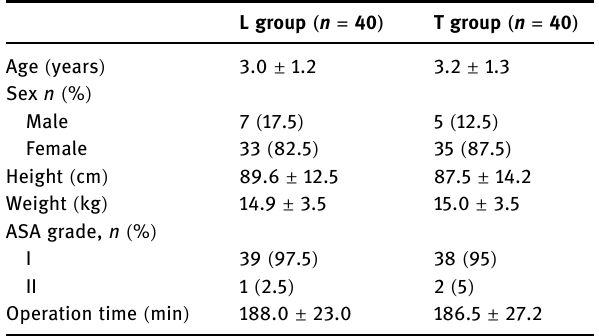
Table 2: Comparison of the regional block between the two